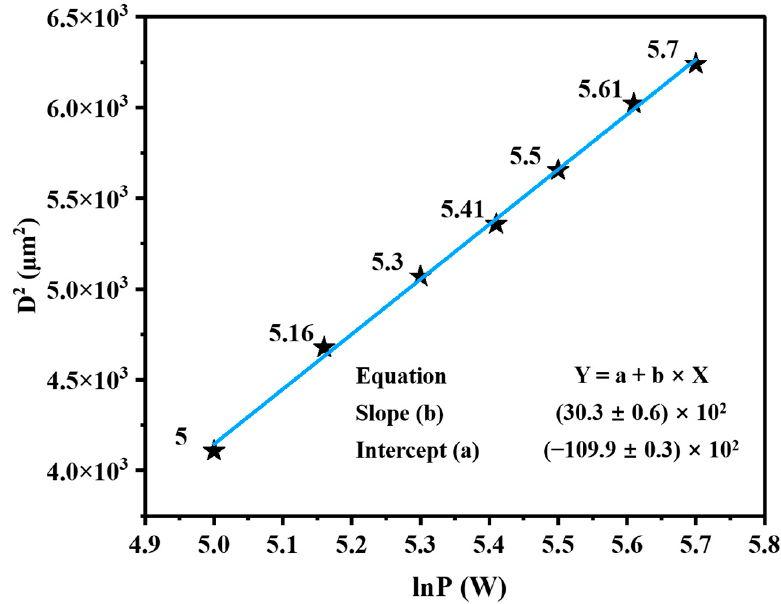
Figure 5. The relationship between InP and D 2 (corresponding to 100 kHz).